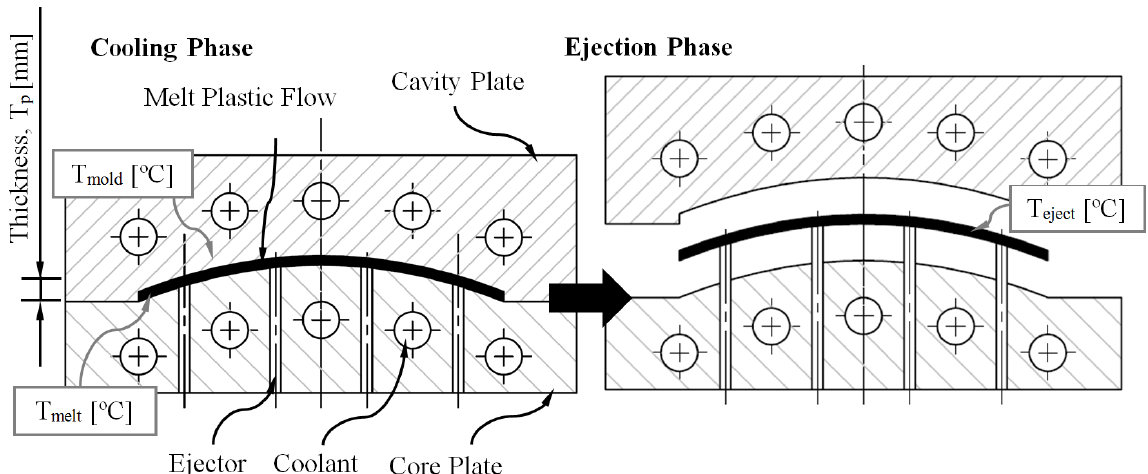
Figure 4. Representation of thermal variables of the physical model.